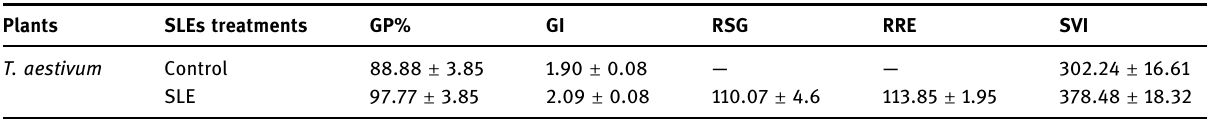
Table 1: Seed germination parameters of T. aestivum L. germination percentage ( GP ) , germination index ( GI ) , relative seed germination ( RSG ) , seedling vigor index ( SVI ) , and relative root elongation ( RRE ) as a ff ected by SLE 2% of S. platensis